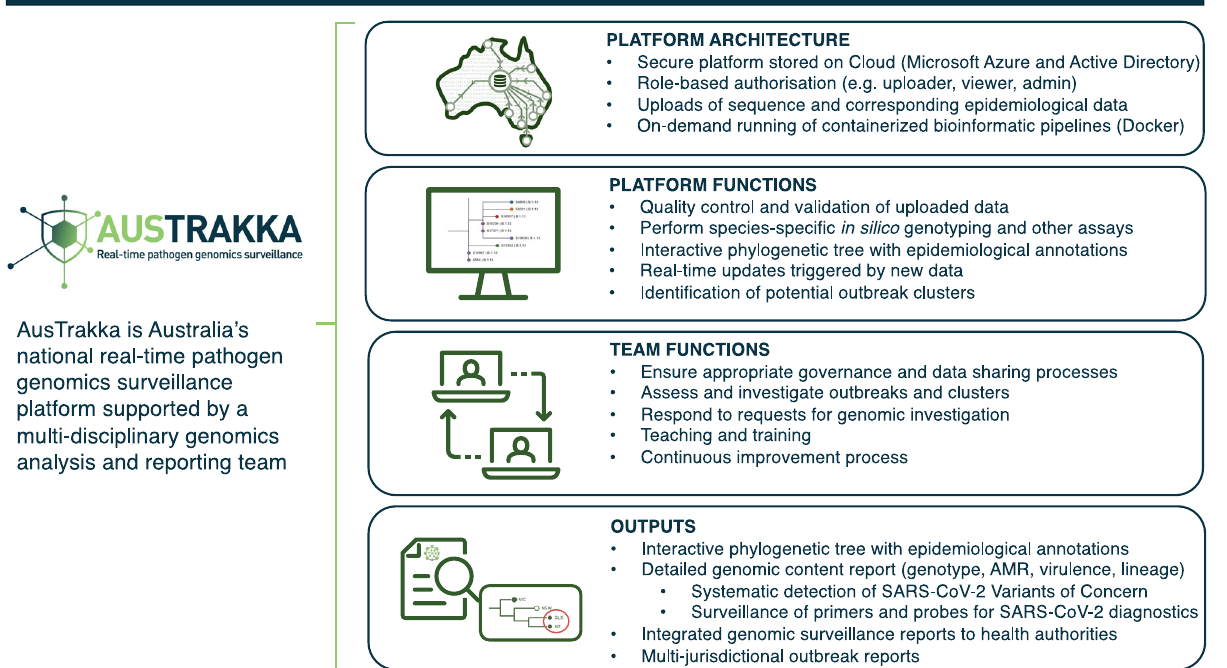
Fig. 1 Overview of AusTrakka platform functions and outputs. The AusTrakka platform accepts sequence and epidemiological data from public health laboratories and performs several functions. Outlined in the fi gure is the platform architecture and functions, team functions and outputs of AusTrakka